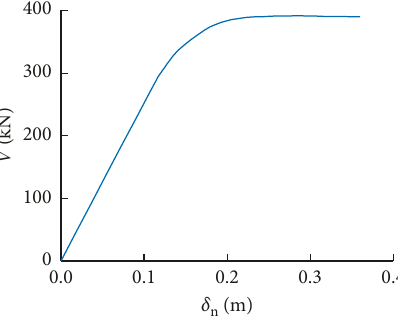
Figure 10: Capacity curve of the frame.